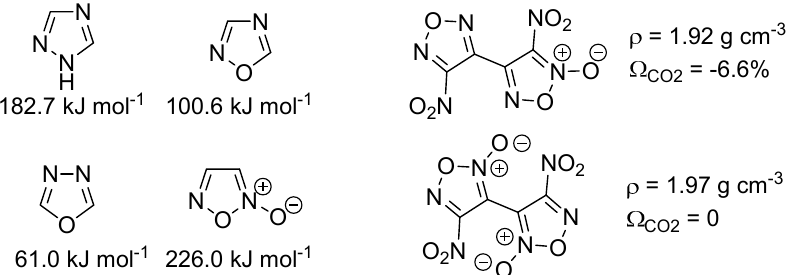
Figure 1. Enthalpies of formation of various azoles and representative furoxan-based HEMs.